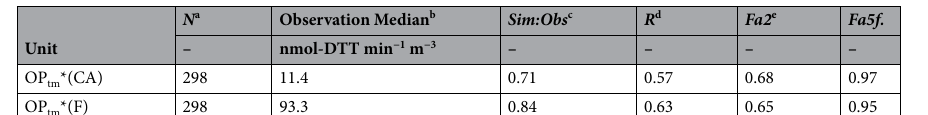
N a Observation Median